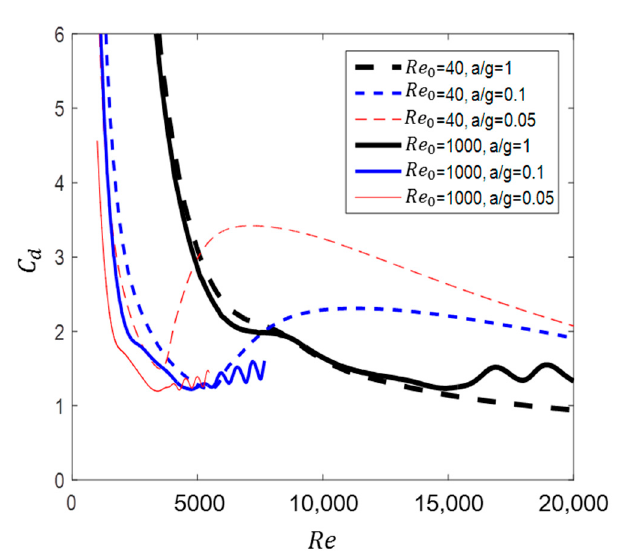
Figure 28. C d versus Re for flow past circular cylinder at two initial velocities Figure 28. 𝐶 (cid:3031) versus 𝑅𝑒 for flow past circular cylinder at two initial velocities